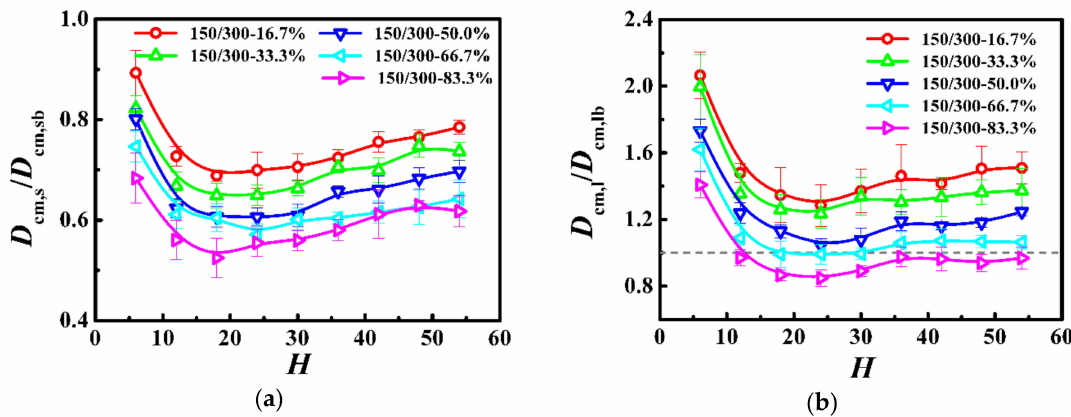
Figure 7. Normalized self-diffusion coefficient of the center-of-mass for ( a ) shorter ( D cm,s / D cm,sb ) and ( b ) longer ( D cm,l / D cm,lb ) chains as a function of the film thickness ( H ) in the model system of N s = 150 and N l =